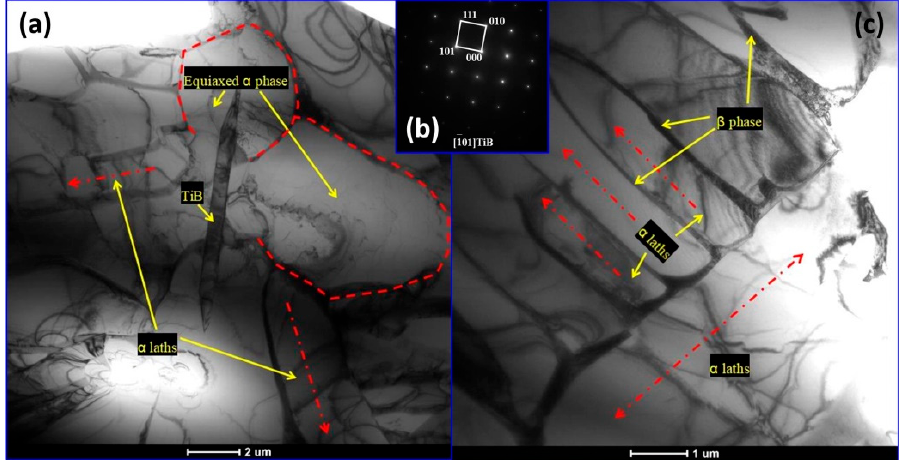
Figure 11. Transmission electron microscope micrographs: ( a ) Bright field image of the TiBw matrix region; ( b ) selected area electron diffraction of TiBw; ( c ) BF image of the α laths and α colony.